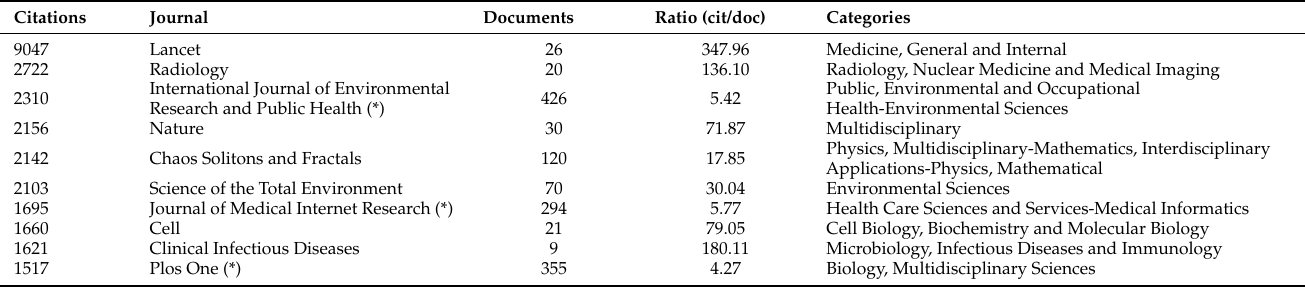
Table 2. Citation by